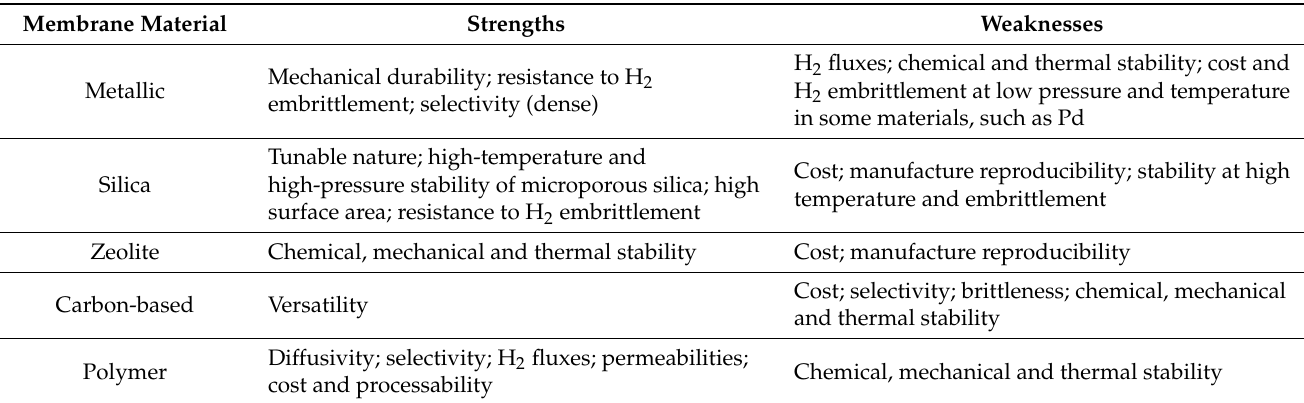
Table 1. Main features of membrane technology for H 2